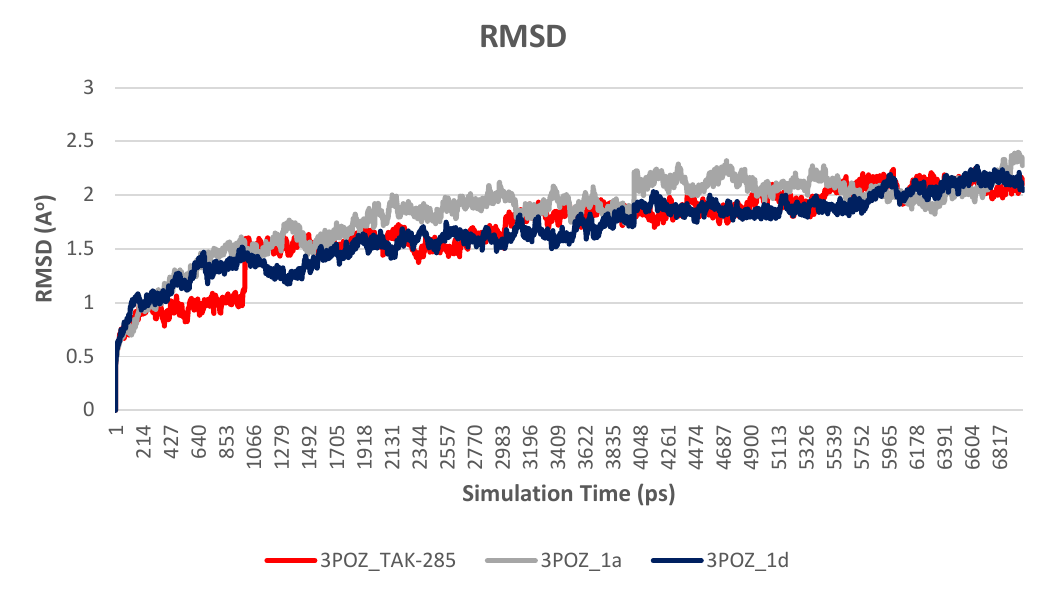
Figure 6. Plot of RMSD vs. time graph for 3POZ-TAK-285 (red), 3POZ- 1a (gray) and 3POZ- 1d (blue), with an average RMSD values of 1.7, 1.8, and 1.7 Å , respectively.